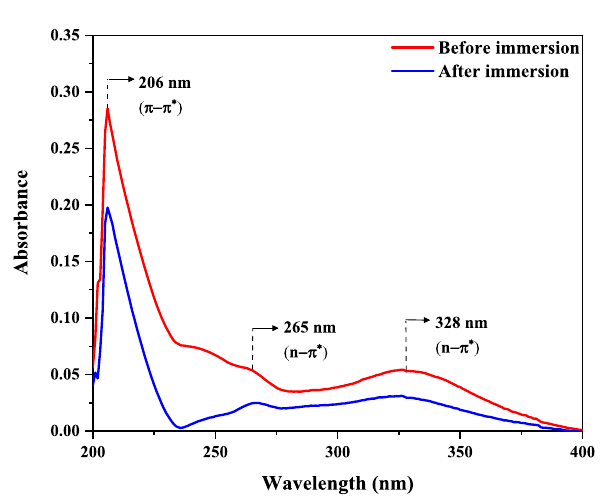
Figure 10. FTIR spectrum of the FV powder and MS immersed in the acidic solution containing 800 ppm FV extract after 6 h of immersion.